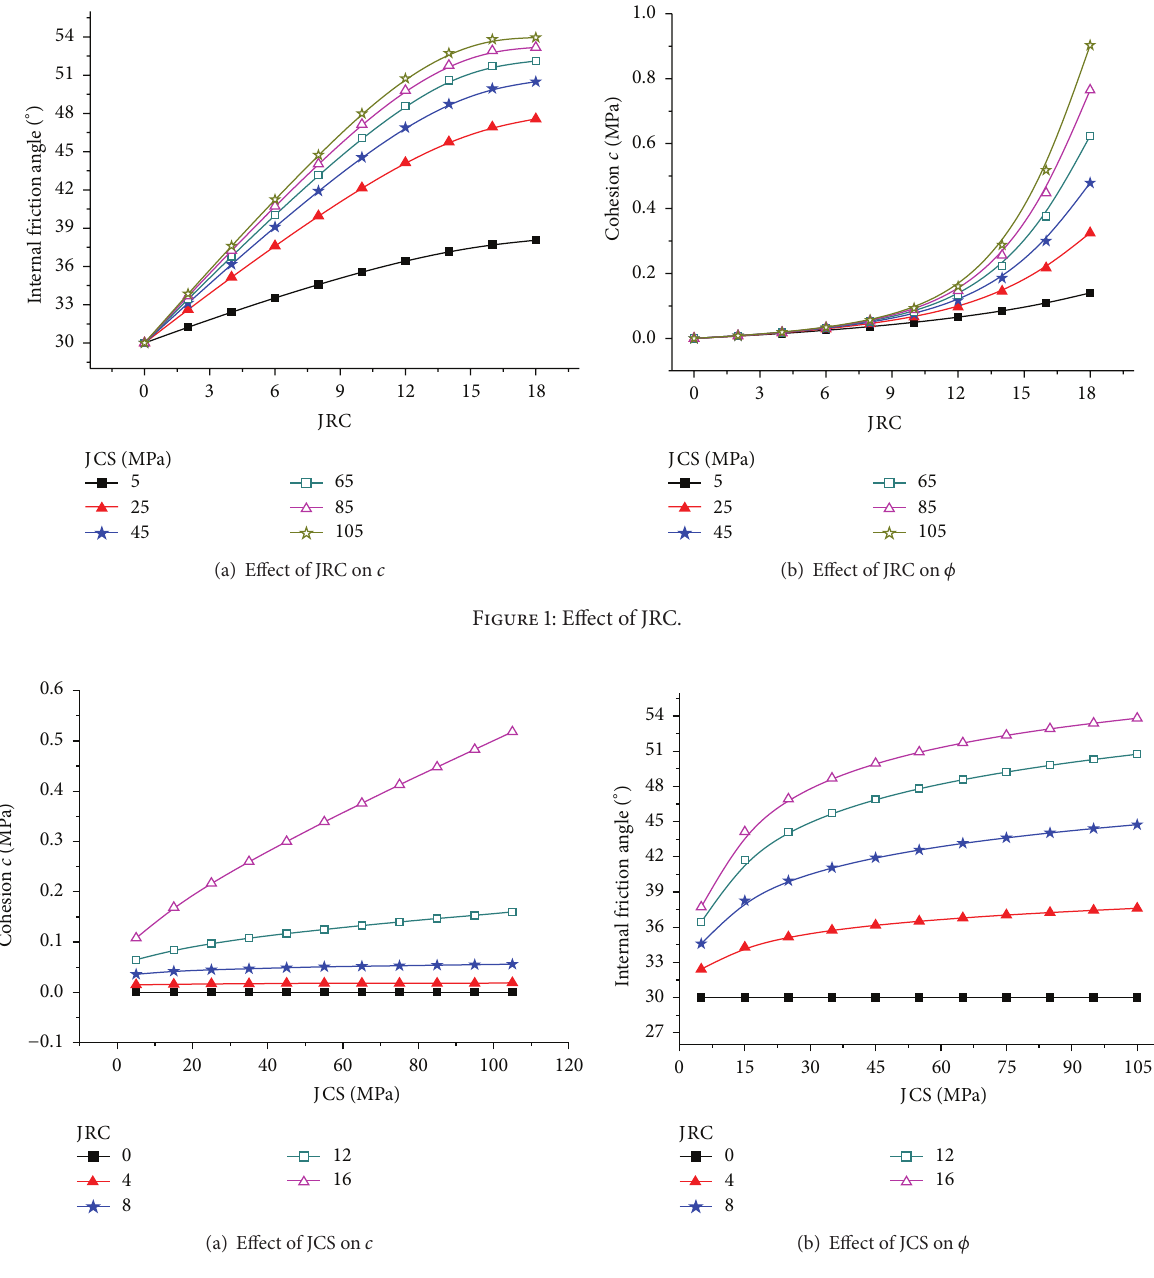
(b) Effect of JCS on 𝜙